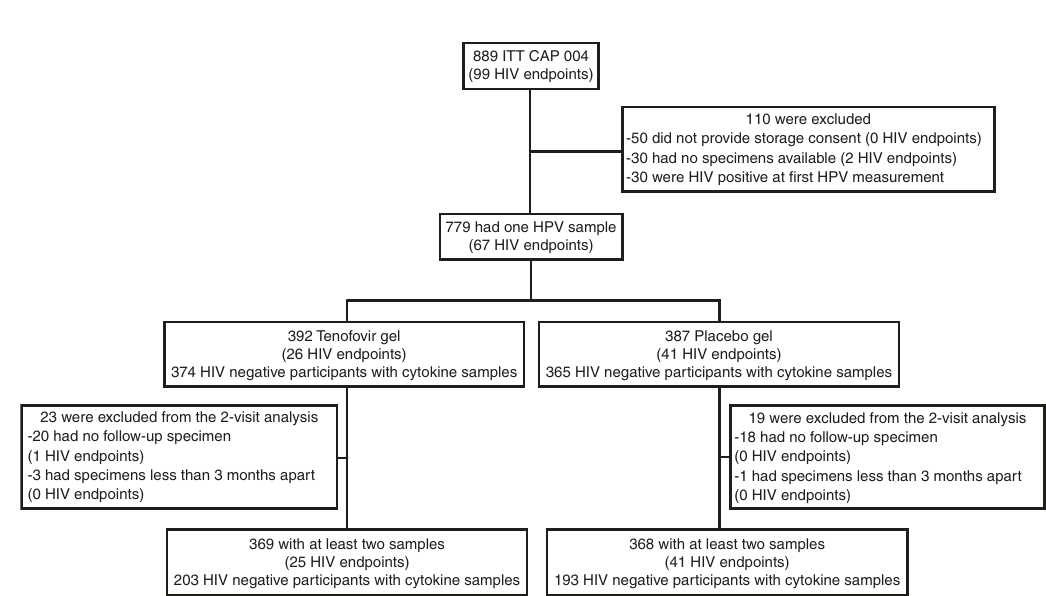
Fig. 1 Enrollment and follow-up of study participants 95% CI: 7.6 – 27.1 for infection with more than 5 HPV types; p < 0.001; Log-rank test for trend; Table 3).